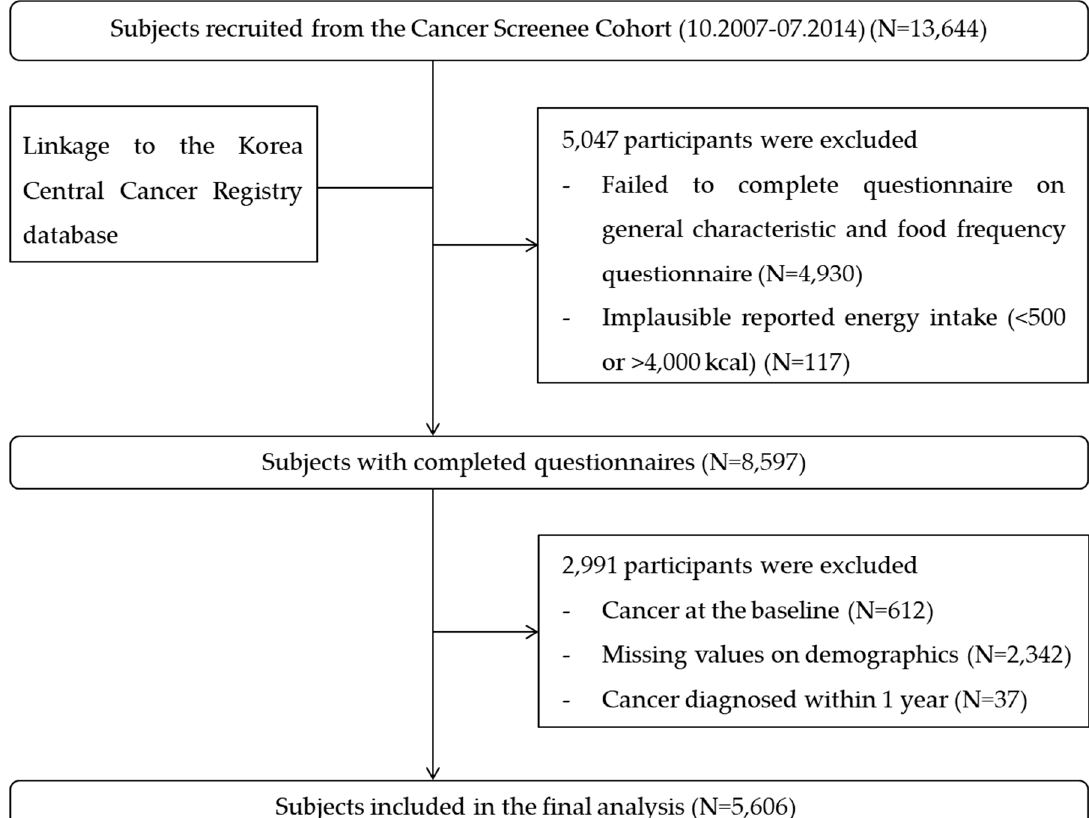
Figure 1. Flowchart of the subject recruitment process.